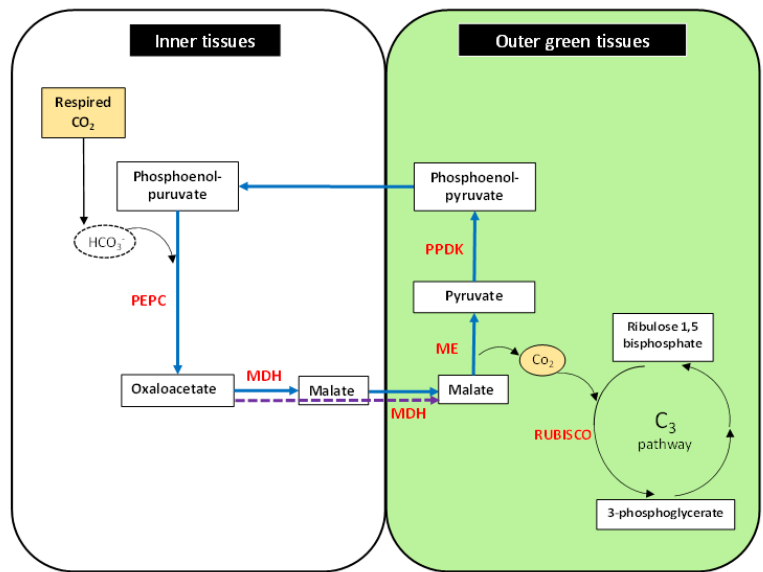
Figure 1. Photosynthesis in non-leaf tissues in outer and inner parts of the organ. Key reactions in inner tissues (without light) to capture respired carbon: PEPC, Phosphoenol-pyruvate carboxylase; MDH, malate dehydrogenase. Reactions in outer tissues (with light): ME, malic enzyme; RUBISCO, Ribulose-1,5-bisphosphate carboxylase/oxygenase; PPDK, Pyruvate orthophosphate dikinase.